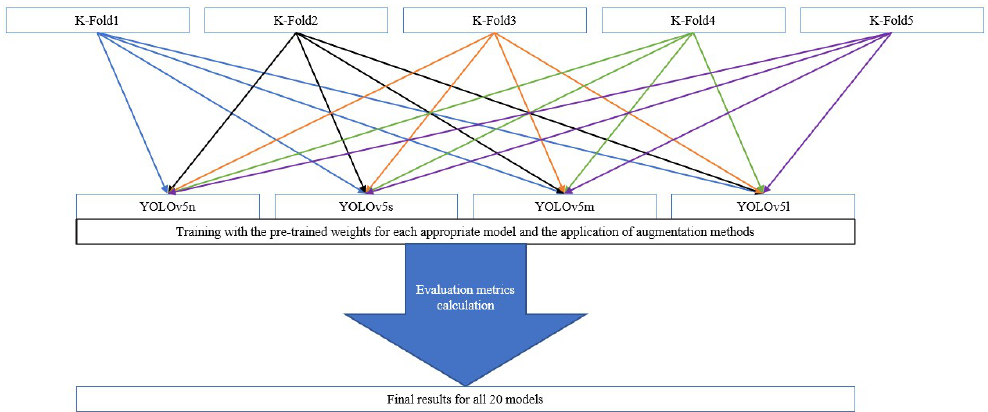
Figure 4. Abbreviated work